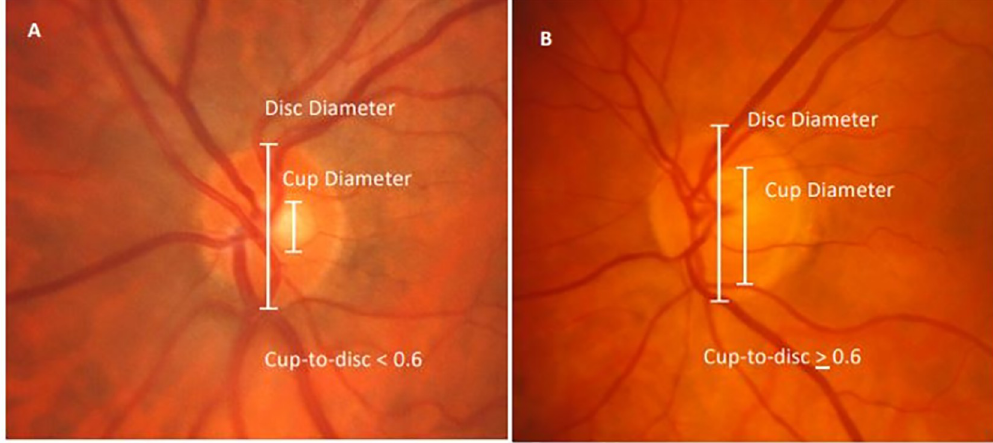
Fig 1. Disc photographs from two WHISE participants, outlining vertical disc and cup diameters with cup-to-disc ratio < 0.6 (A), and cup-to-disc ratio � 0.6 (B).